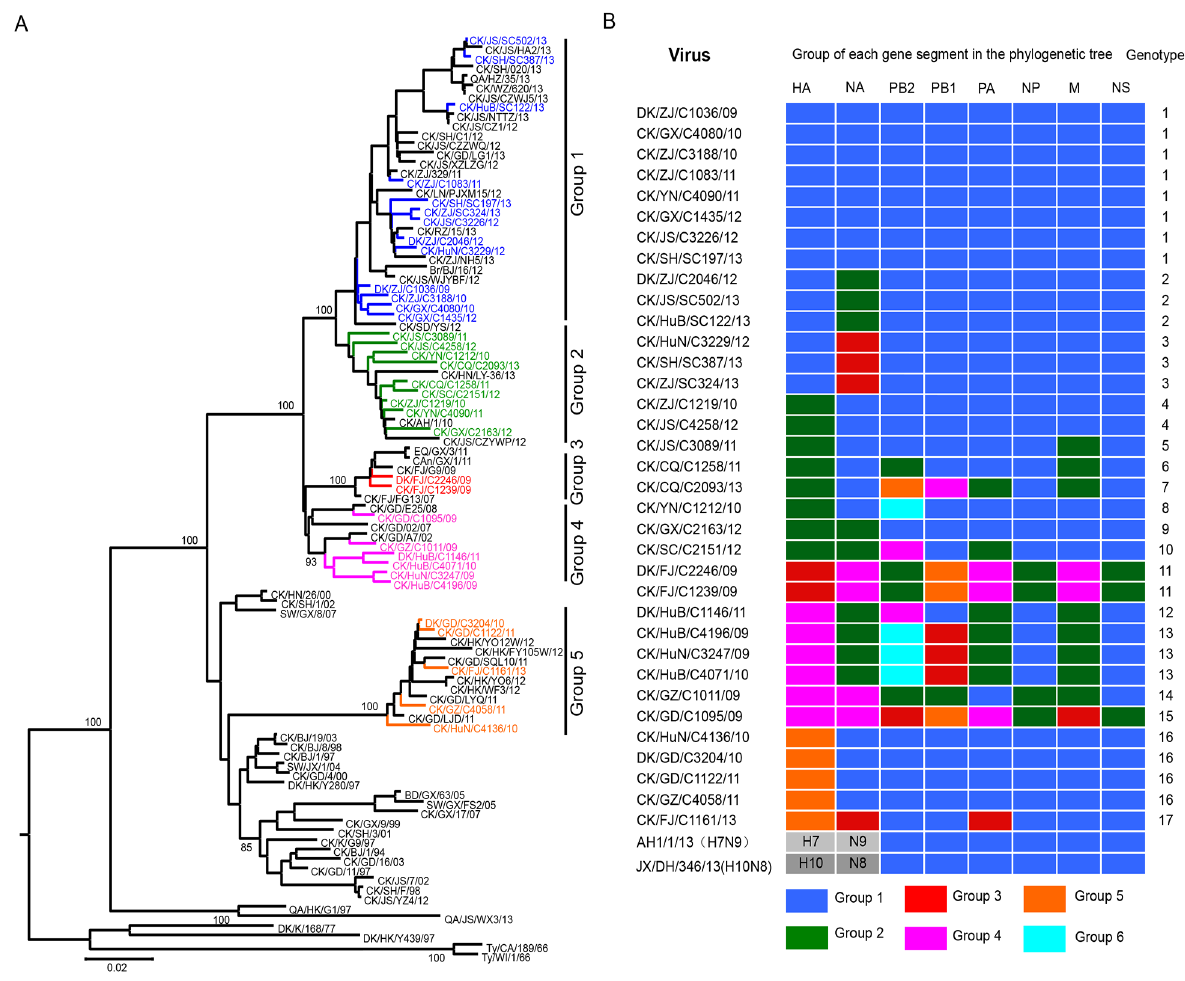
Figure 1. Genetic relationships among the HA genes and genotype evolution of H9N2 viruses. ( A ) Phylogenetic tree of HA. The tree was based on nucleotides (nt) 128 to 1540 and rooted to A/Duck/Alberta/60/76(H12N5). Sequences of viruses with names in black were downloaded from available databases; viruses with names in other colors were sequenced in this study. Abbreviations are as follows: Br, Brambling; CAn, Canine; CK, Chicken; DK, Duck; Env, Environment; GS, Goose; Pg, Pigeon; QA, Quail; SW, Swine; Ty, Turkey; AH, Anhui; BJ, Beijing; CA, California; CQ, Chongqing; DH, Donghu; FJ, Fujian; GD, Guangdong; GX, Guangxi; GZ, Guangzhou; HZ, Hangzhou; HN, Henan; HK, Hong Kong; HuB, Hubei; HuN, Hunan; JS, Jiangsu; SD, Shandong; SH, Shanghai; TZ, Taizhou; WI, Wisconsin; XZ, Xuzhou; YZ, Yangzhou; YN, Yunnan; ZJ, Zhejiang. ( B ) Genotypes of the H9N2 viruses. The eight gene segments are indicated at the top of each bar.